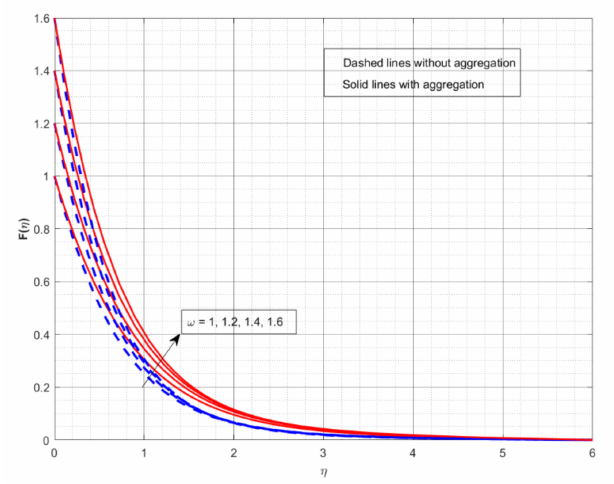
Figure 4. The impact of rotation-strength parameter on the velocity profile F ( η )